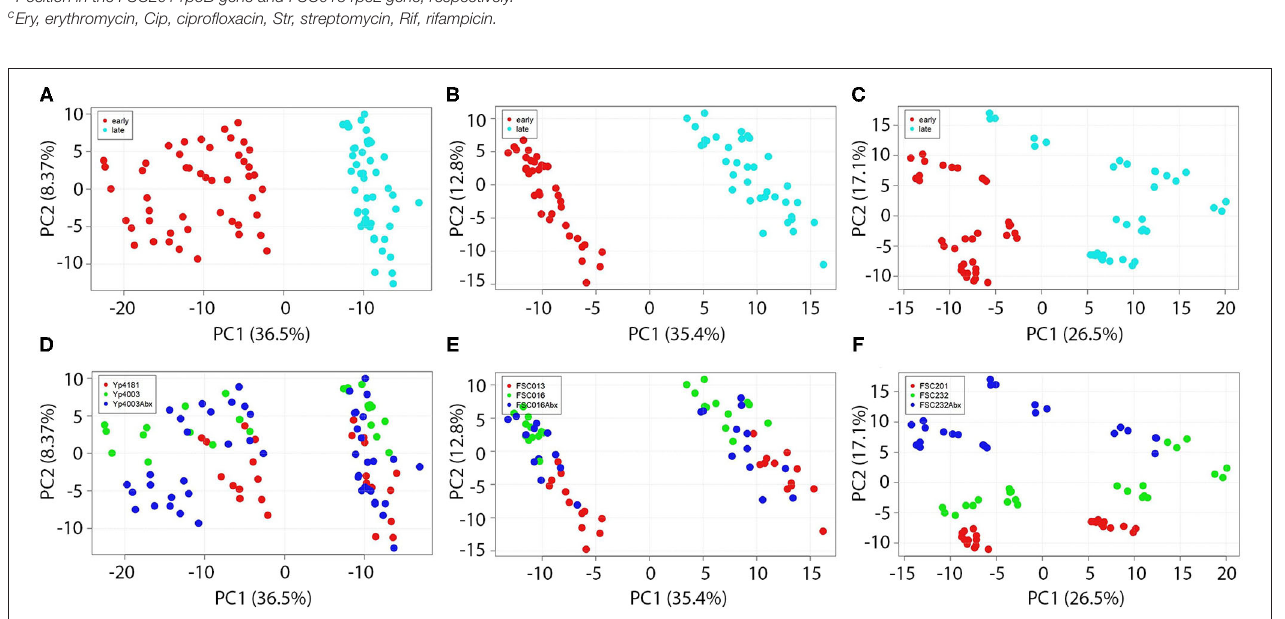
FIGURE 1 | Growth phase significantly influences protein expression, whereas presence of antibiotics produces more subtle effects. Growth phase significantly impacts protein expression in both Y. pestis (A) and F. tularensis (B,C) . Proteins observed in biomass sampled at early (mid-log) and late (stationary) growth phases from each AMR/AMS strain pair were subjected to Principal Component Analysis (PCA). The clear separation between samples from early vs. late time points is readily apparent in panels (A–C) . Presence of antibiotics in growth media had less significant effects on protein expression (D–F)